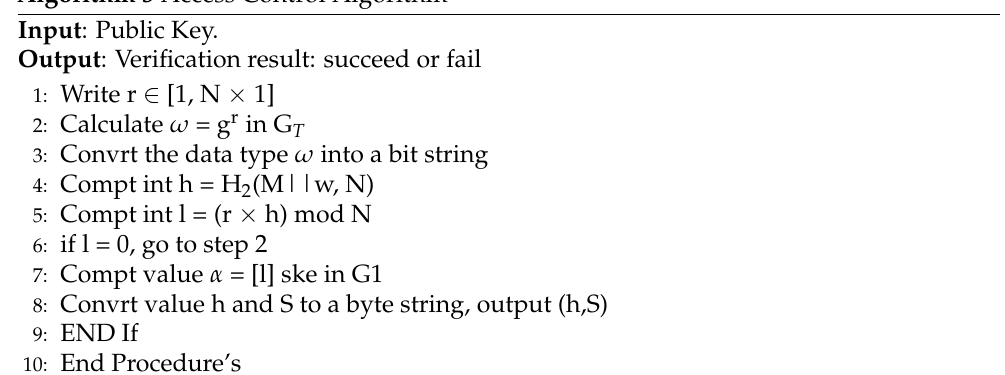
Algorithm 3 Access Control